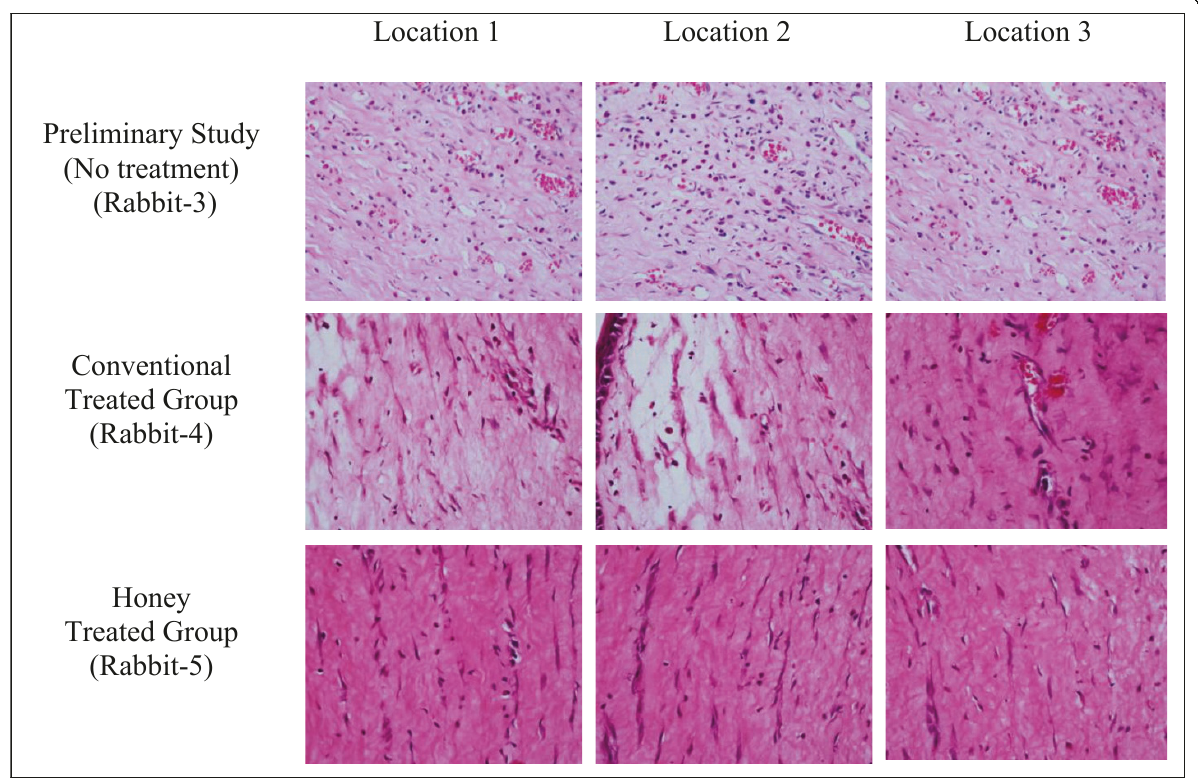
Figure 3 Histopathological inflammatory features on day 7 post induction of alkali injury on rabbit ’ s cornea